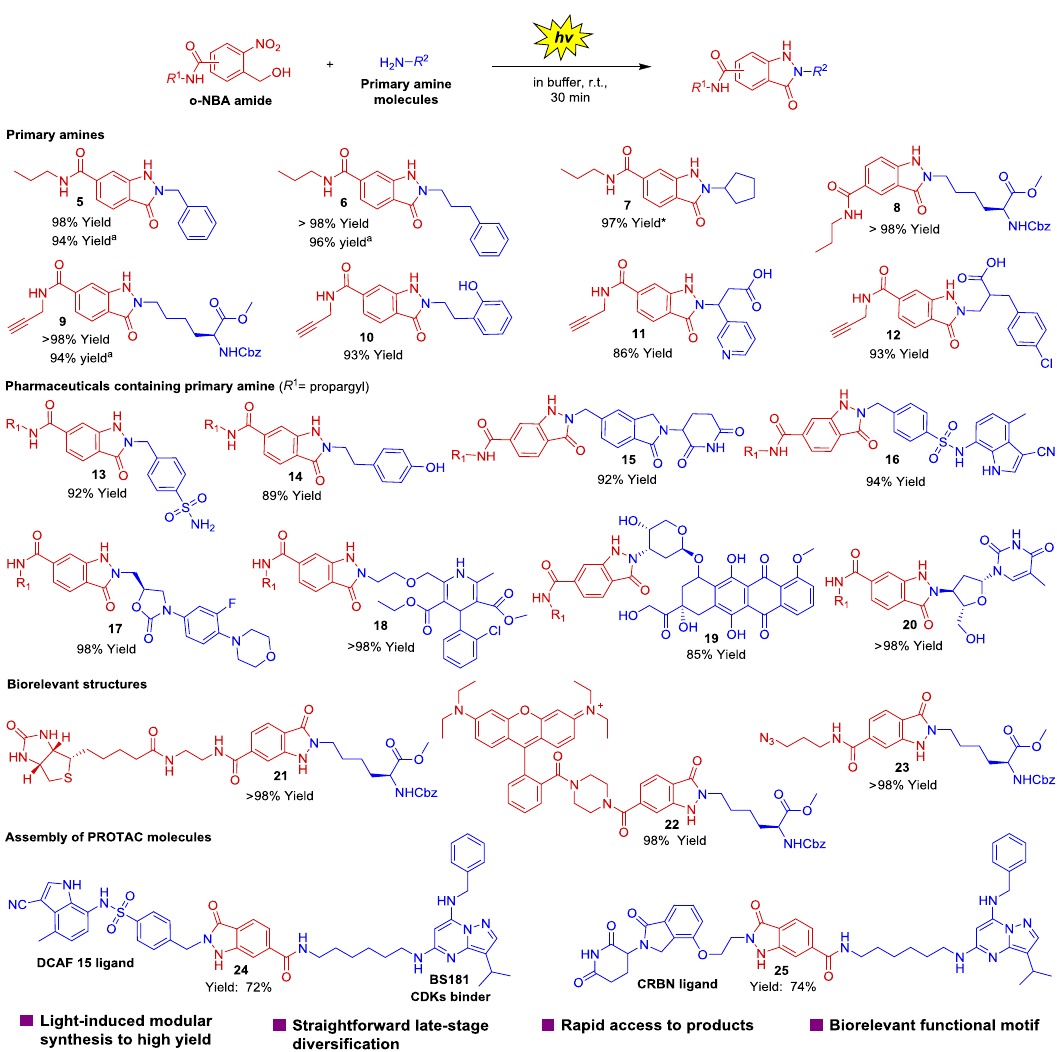
Fig. 3 Light-induced modular functionalization of primary amines, straightforward late-stage diversi fi cation of pharmaceuticals, and rapidly assembly of PROTACs. Reaction conditions: amine (500 μ M) and o -NBA derivatives (2 mM) in 100 mM PBS/MeOH (2:1, pH = 7.4) were treated with 365 nm UV light for 7 min and incubated at 25 °C for 30 min. *The concentration of o -NBA amide was 4 mM. For compound 10 / 11 / 13 , the substrates were irradiated for 10 min. For compound 22 , the substrates were irradiated for 15 min. Yields were determined by ratio of peak area value of experiment to that of internal standard product on reverse-phase HPLC, are reported as an average of three independent trials, see Supplementary Information for HPLC trace. a With the scale of 0.1 mmol amine,